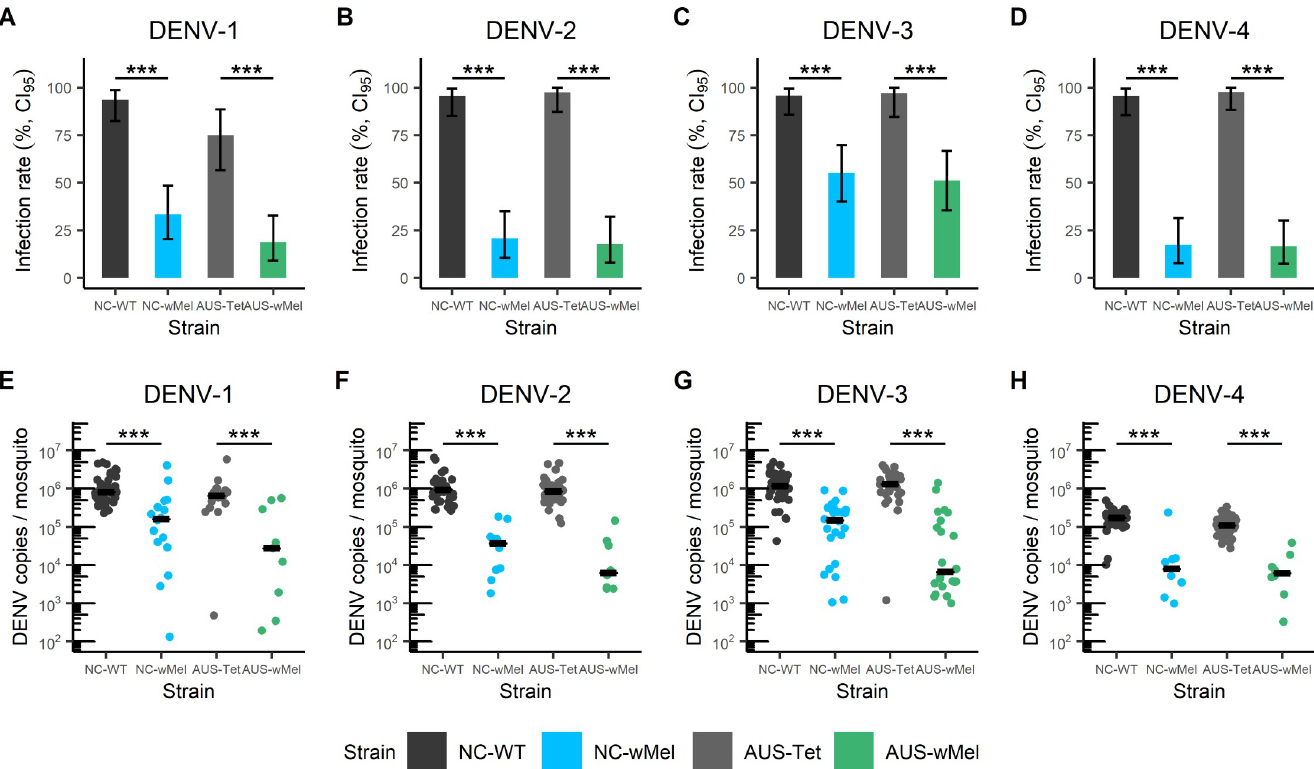
Fig 2. NC-WT, NC- w Mel, AUS-Tet and AUS- w Mel Aedes aegypti strains intrathoracically injected with the four DENV serotypes. (A, B, C, D) Infection rates obtained for DENV-1, DENV-2, DENV-3, and DENV-4 respectively at 7 days post-injection. Errors bars indicate Confidence Interval at 95%. (E, F, G, H) Viral titers obtained from infected mosquitoes at 7 days post-injection, for DENV-1, DENV-2, DENV-3, and DENV-4 respectively. Median is shown for each mosquito strain. Statistically significant differences are shown in the figures (Fisher’s exact test for infection rates; Wilcoxon test for viral titers; � : p -value < 0.05; �� : p -value < 0.01; ��� : p -value < 0.001; NS: not